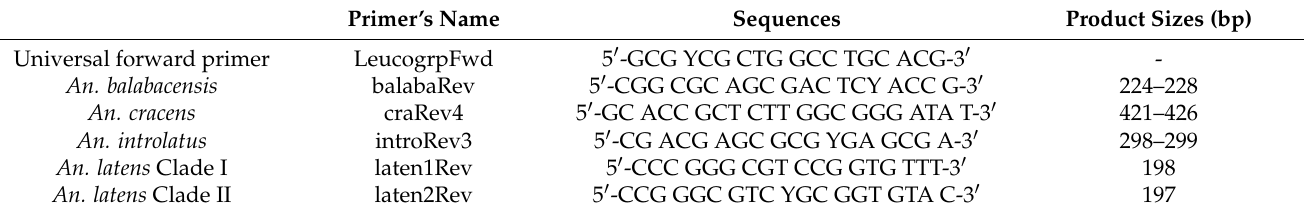
Table 1. Universal forward primer and the five Anopheles species-specific reverse primers (from this study) for An. latens , An. introlatus , An. cracens , and An. balabacensis with the sequences and the product